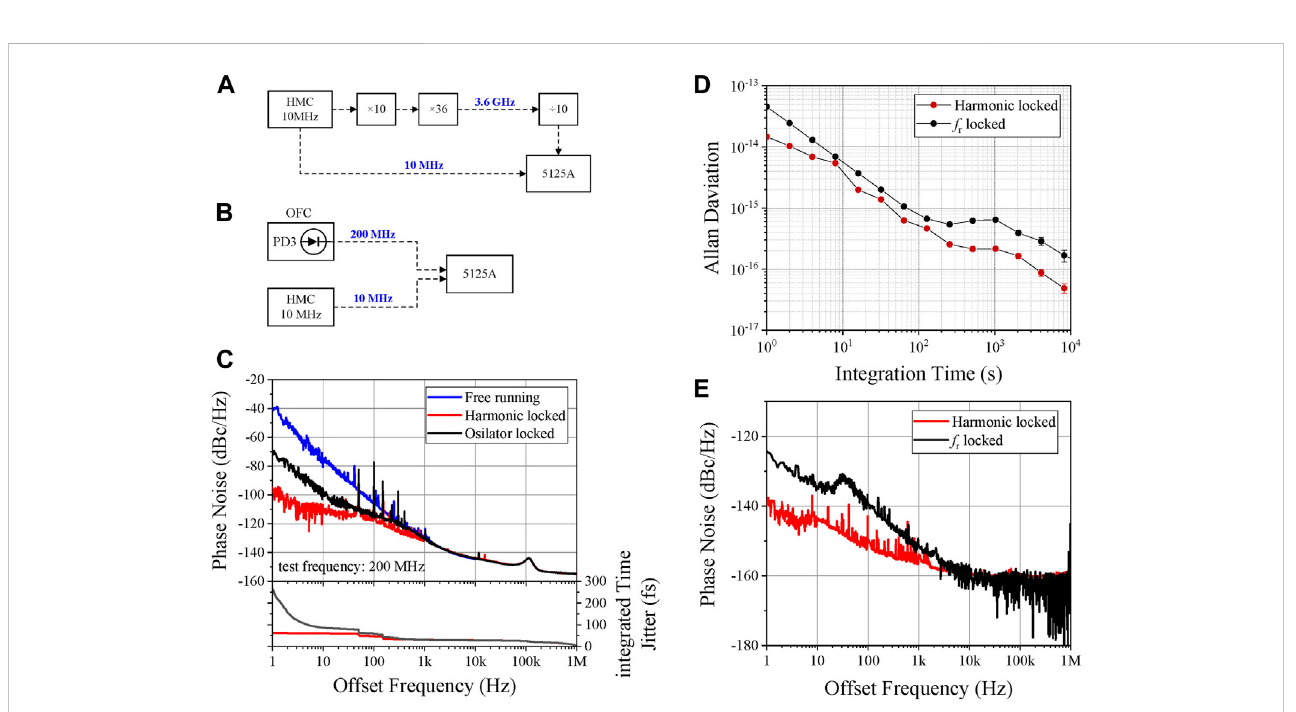
frequency detected by PD3. Using the harmonic phase locking method, the phase noise of the OFC is well suppressed, which declines from − 43 dBc/Hz to − 96 dBc/Hz at 1 Hz offset. The corresponding absolute RMS timing jitter of the repetition rate is 62 fs from 1 Hz to 1 MHz. Moreover, we also test the phase noise and the absolute RMS timing jitter of the out-of-loop optical power ampli fi cation. The results are shown with the black lines in Figure 6D. The phase noise of the OFC with the out-of-loop EDFA is − 70 dBc/Hz at 1 Hz offset, and the absolute RMS timing jitter is 264 fs from 1 Hz to 1 MHz, which is much higher than the in-loop design. This indicates that in-loop optical power ampli fi cation can well suppress the phase noise caused by the EDFA.